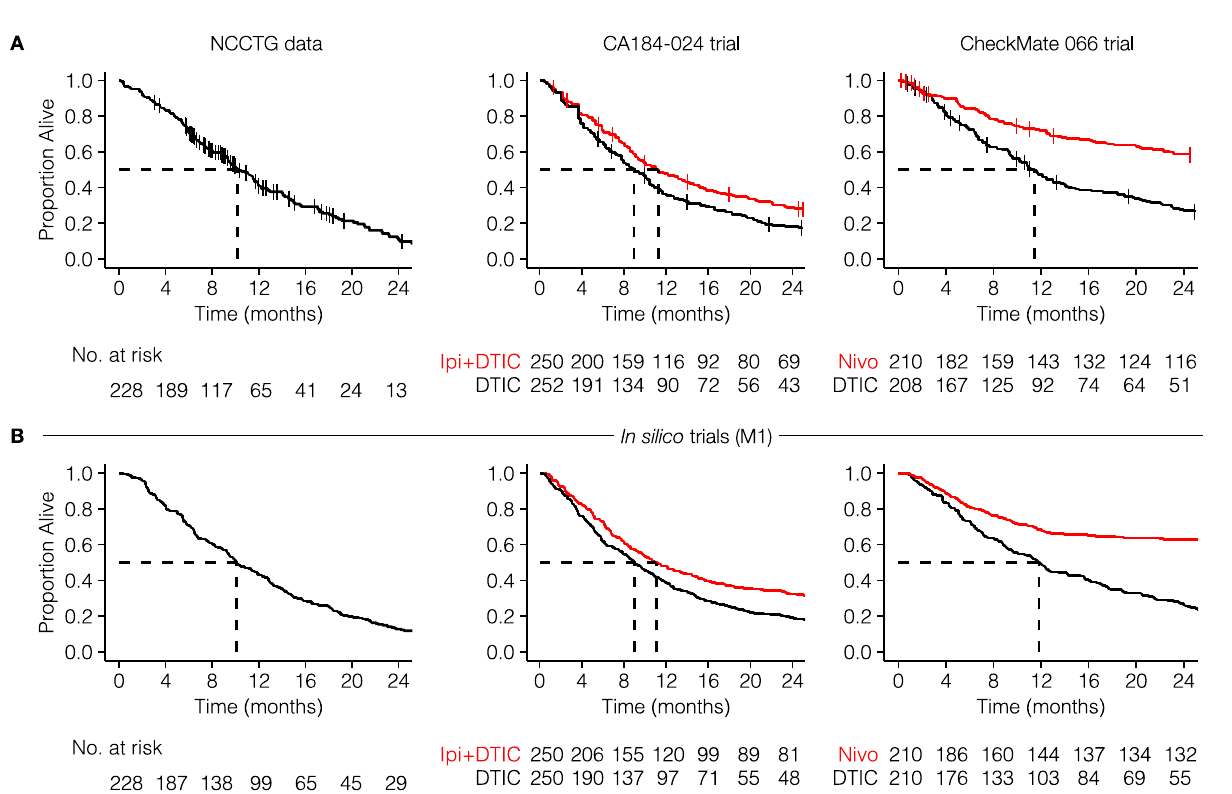
Fig. 2 | Simulating immunotherapy responses using different mathematical models. Eachsimulationstartswithasinglemalignantcellthatestablishesatumor. Withouttreatment,thistumorgrowstoalethalvolume(upperhorizontalline)over the course of several months; the plotsstart when the tumor hasa sizeof10 8 cells. Treatment is started when the tumor reaches a size of 65×10 8 cells (lower hor- izontal line). Immunotherapy is implemented in each model by increasing the rate at which T cells kill tumor cells; in M2, the death rate of T cells is additionally